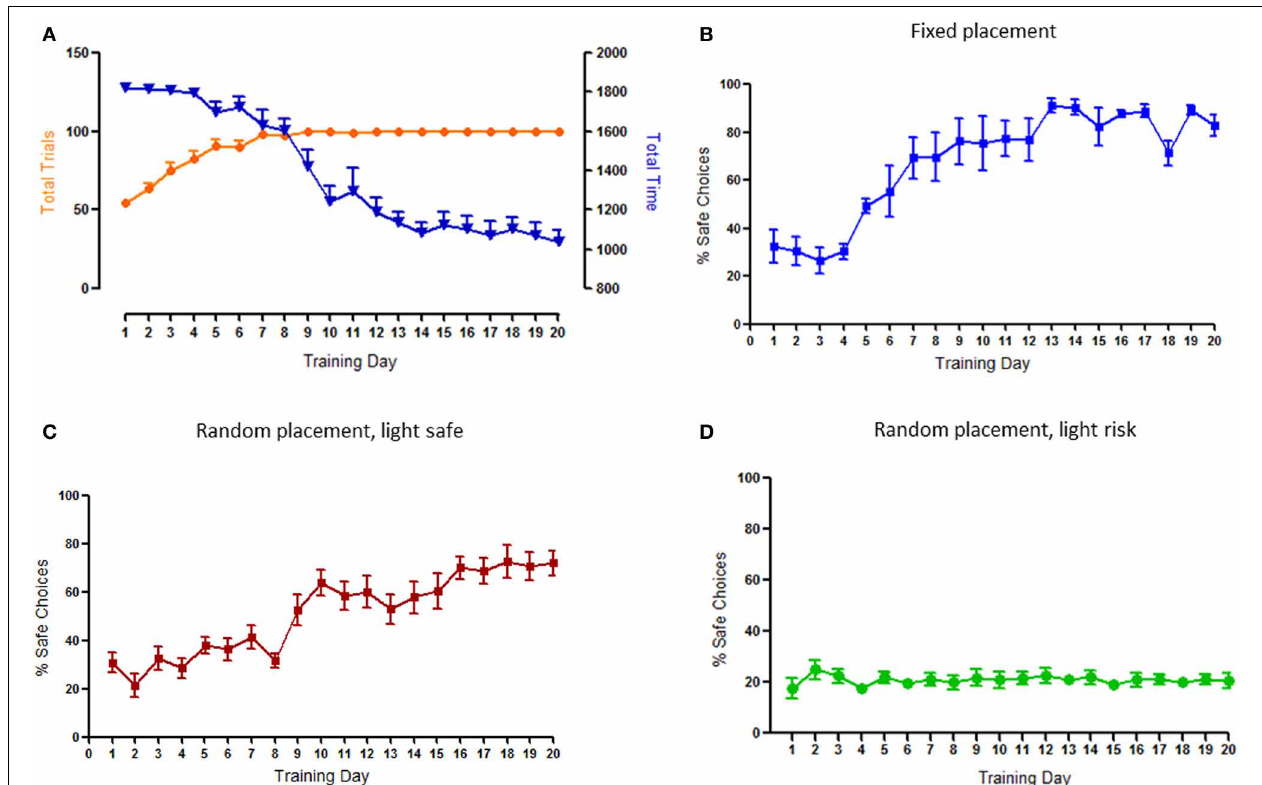
FIGURE 2 | Behavioral characterization of the task and effects of environmental cue modeling on risk-based decision. (A) Total time and number of trials by session. Animals significantly decreased the total session time and increased the number of trials per session until the maximum of 100 in the first 2 weeks. (B) Pattern of choices using a fixed placement of the safe nose-poke hole. Animals increase their preference for safe choices to more than 80%. (C) Pattern of choices